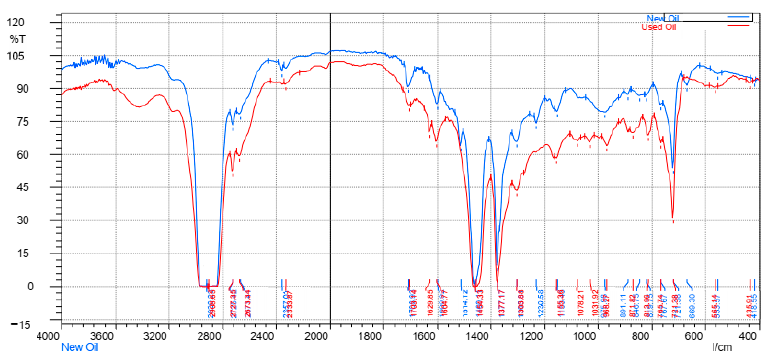
Figure 8. Superposition of IR spectra: new and used oil.